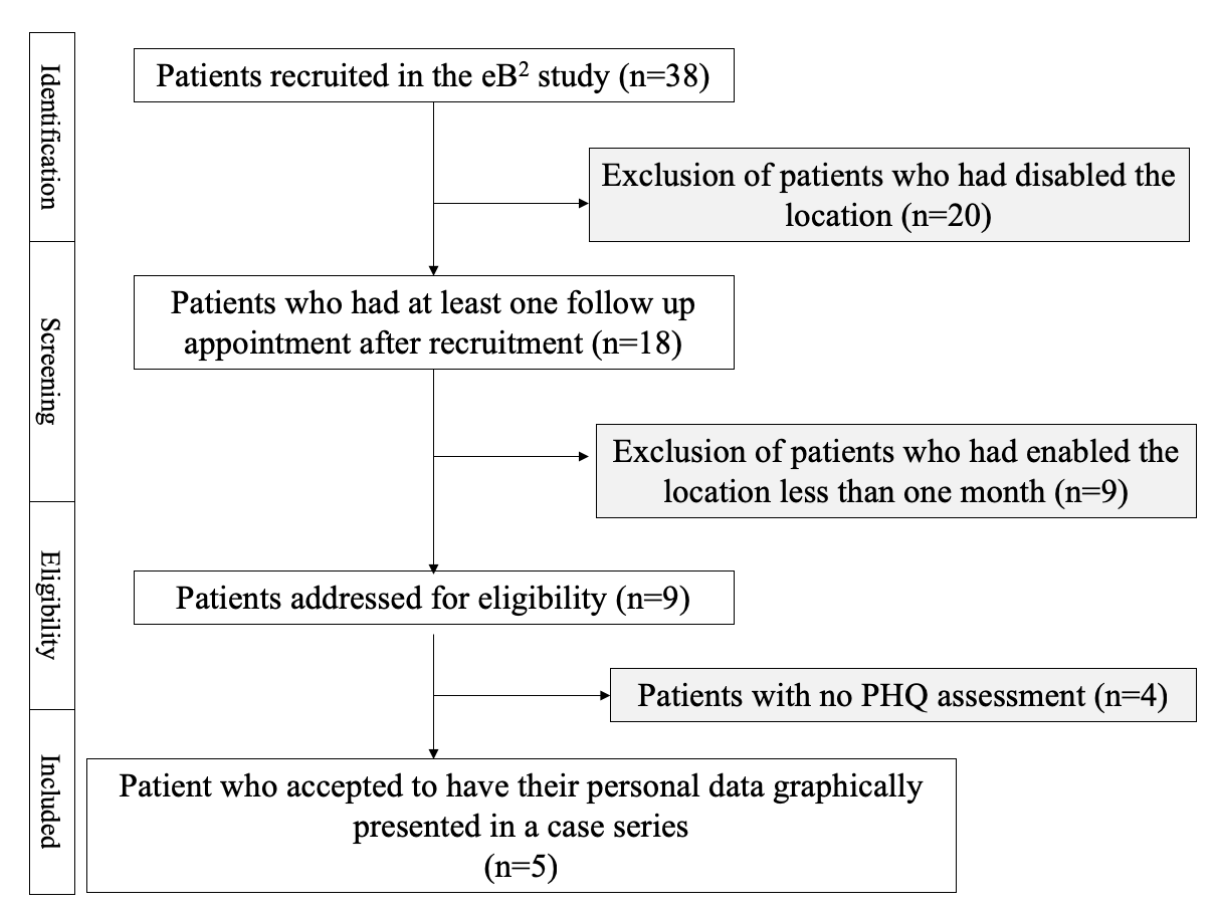
Figure 2. The patient selection process. eB 2 : Evidence-Based Behavior; PHQ: Patient Health